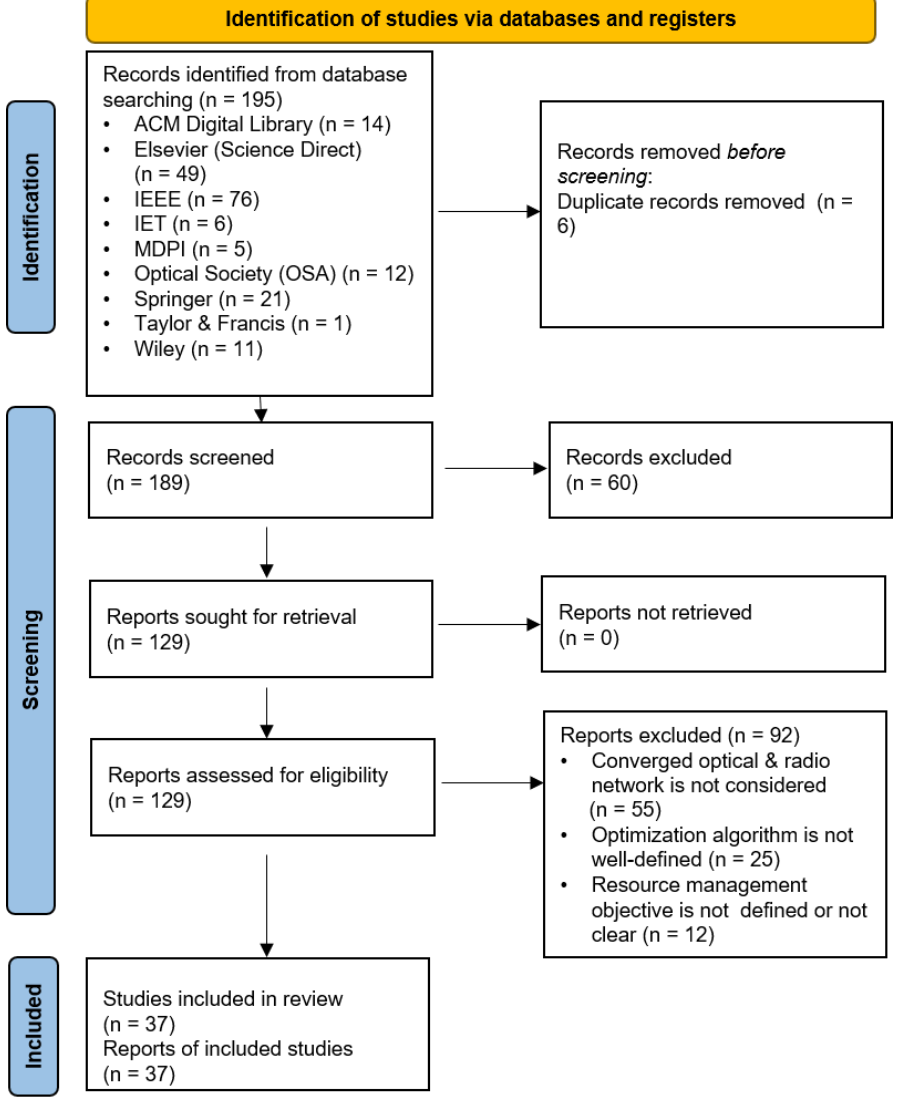
Figure 2. Paper selection phases of the review